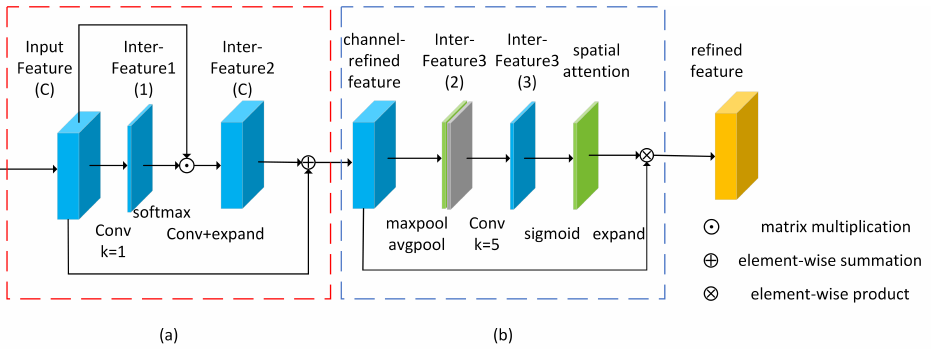
Figure 3. The structure of SA-FPN, ( a ) shows the structure of the SNL, which we use to build channel- level attention, and ( b ) shows the structure of the spatial-level attention building module. Note that on the low-level feature map, we only used part ( a ) of this module to obtain the refined